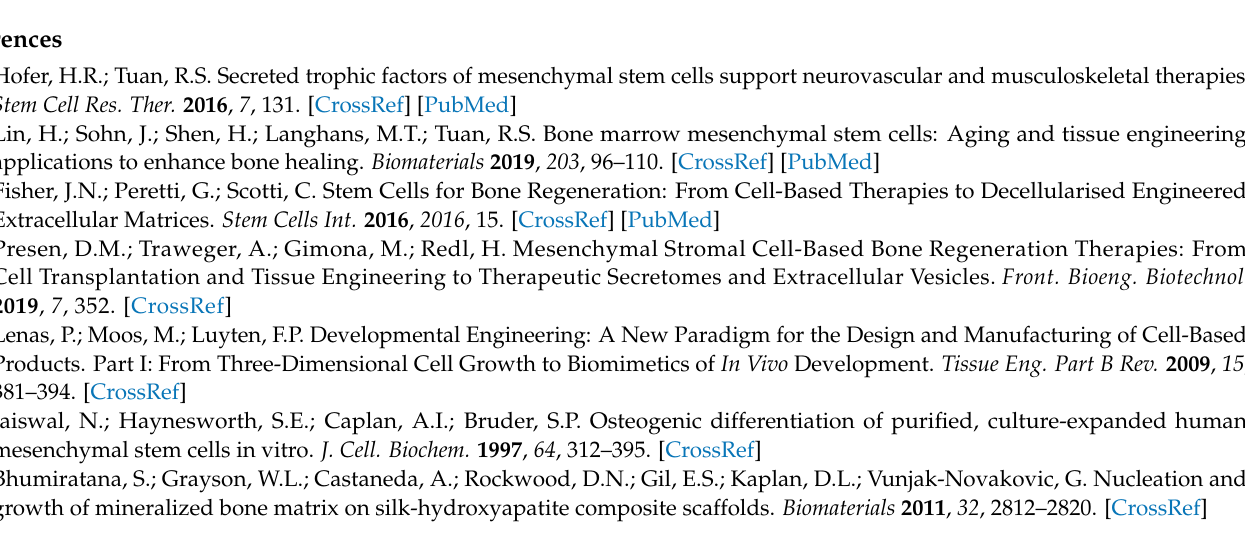
Figure S3: Construct mechanical properties pre-implantation, Figure S4: Mineral deposition in cul- tured constructs preimplantation, Figure S5: Presence of M1 macrophages, Figure S6: